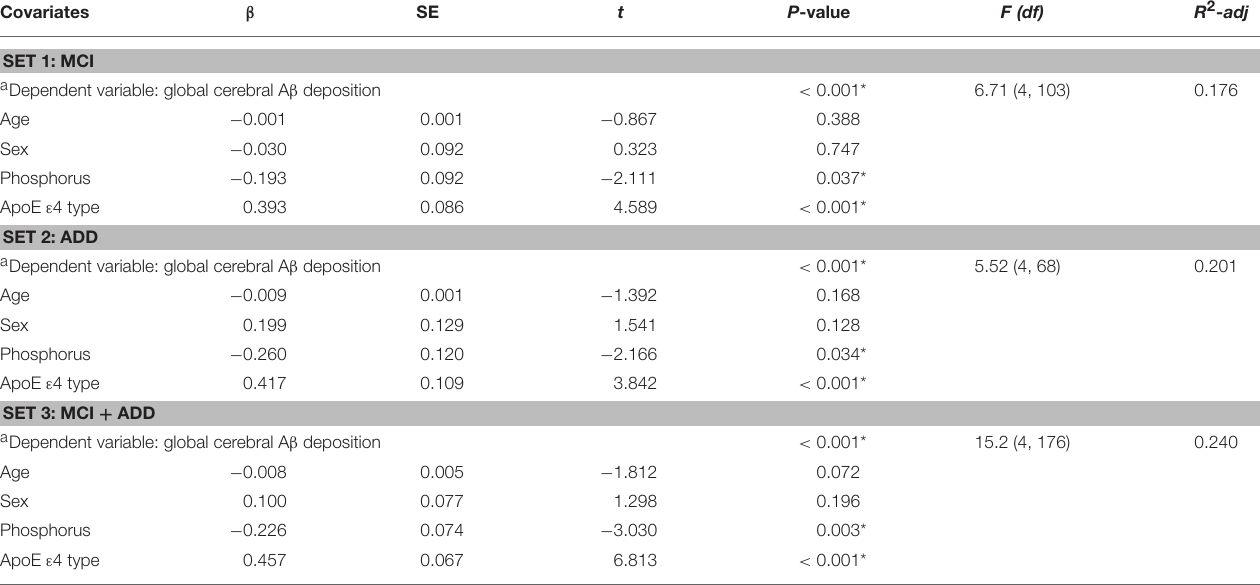
TABLE 3 | Multiple regression analyses of phosphorus and global cerebral A β deposition. Covariates β SE t P -value F (df) R 2 -adj